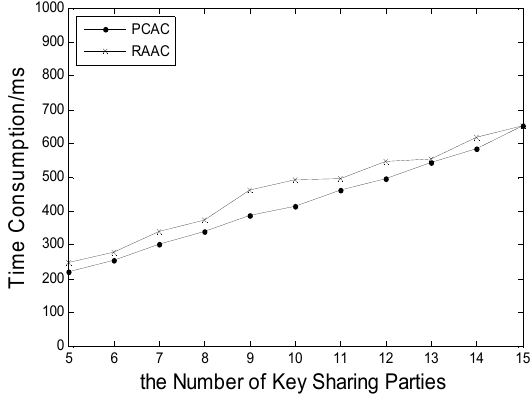
Figure 5. Time Consumption in the Data collection